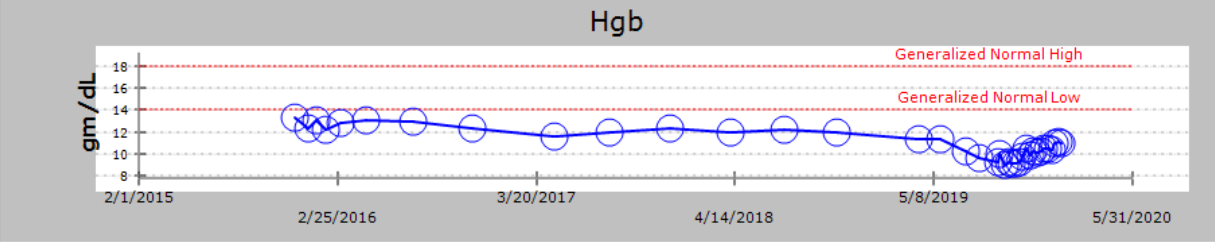
Figure 4. Graphical trend of hemoglobin.